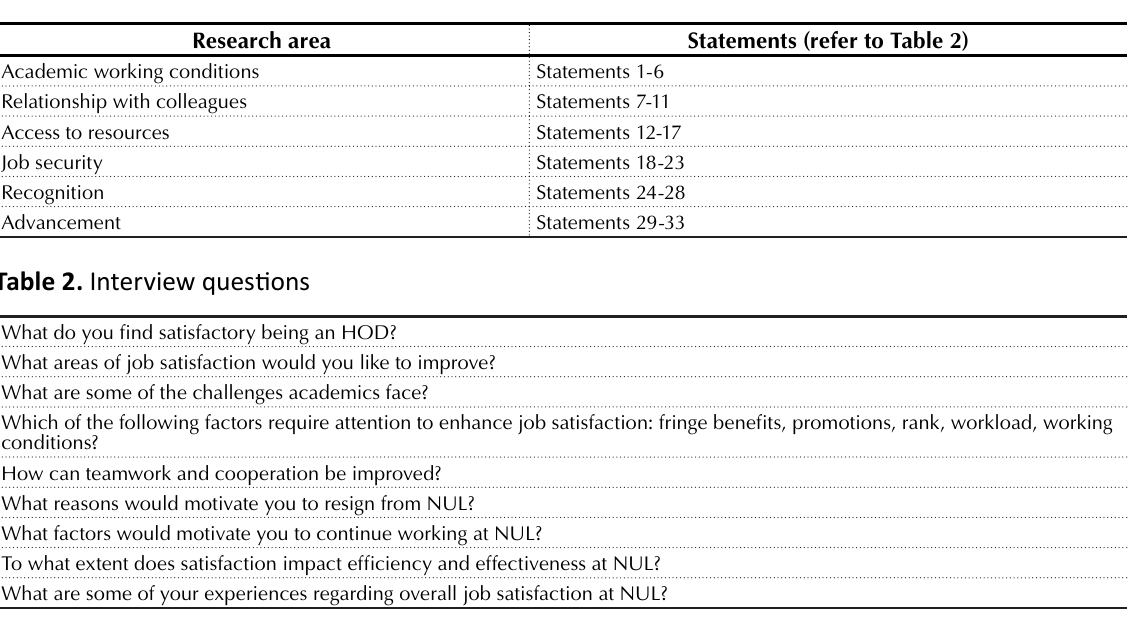
Table 1. Summary of questionnaire